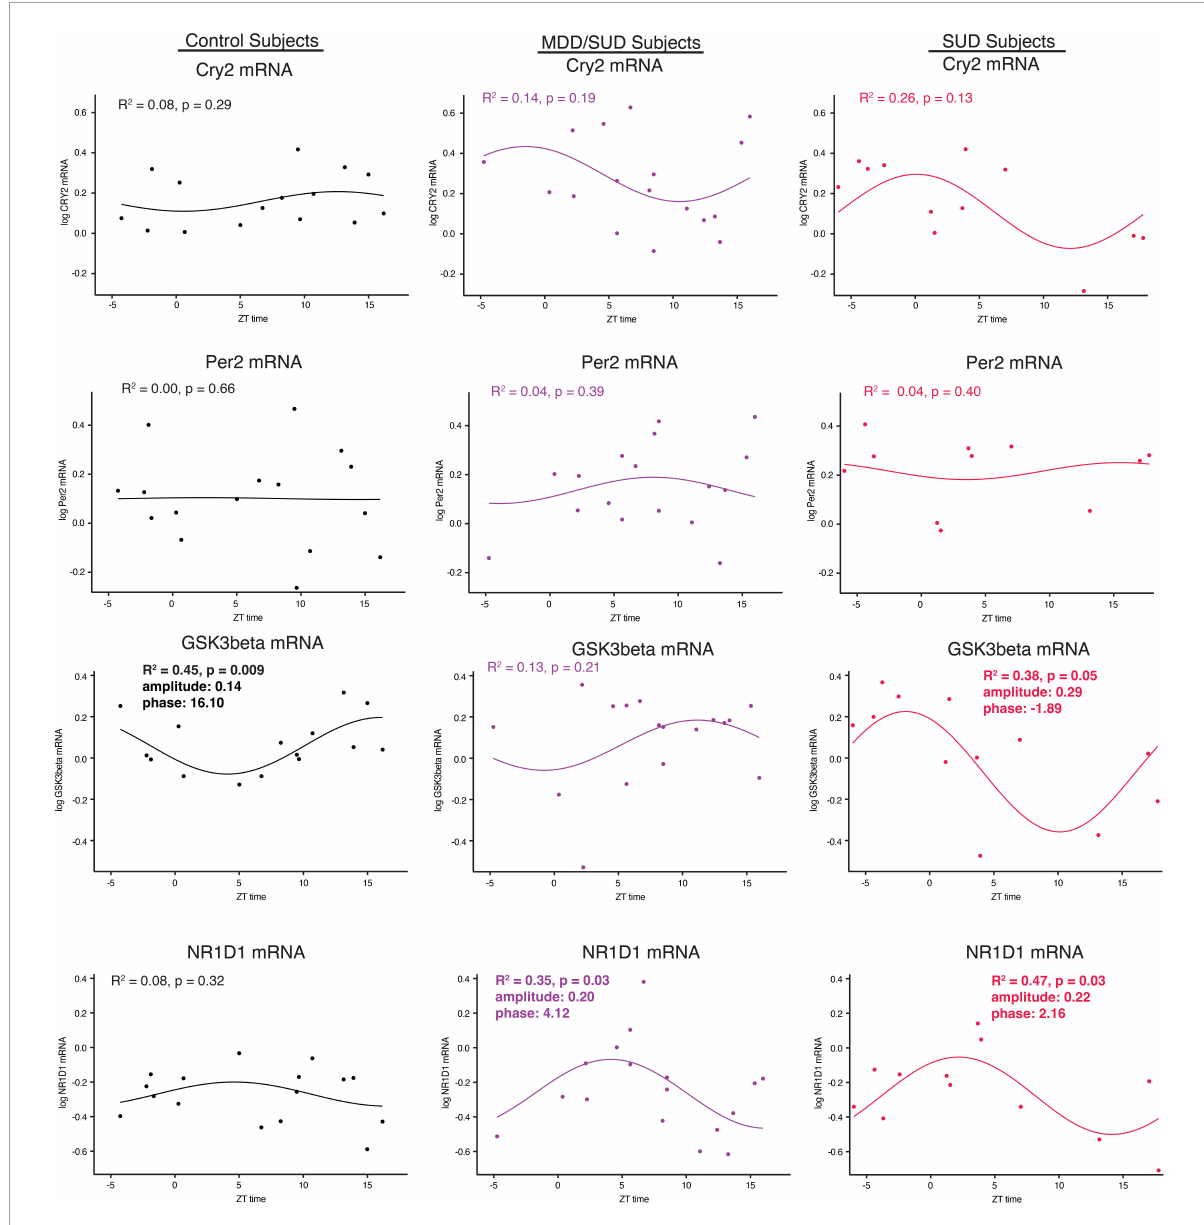
FIGURE7 Diurnal clock gene expression rhythms. Diurnal gene expression rhythms for clock genes in the human hippocampus. Expression level values in the scatterplots are indicated on the y axis with each dot representing an individual subject and the x axis representing ZT time of death values. The colored lines represent the fit sinusoidal curve for each marker in each diagnosis group. R 2 values and corresponding p -values represent significance of fit for diurnal expression rhythms. Significant diurnal expression rhythm was observed for Gsk3 β in control subjects. Enhanced rhythms were observed in subjects with SUD for Gsk3 β and Nr1d1 gene expression and for Nr1d1 in subjects with MDD/SUD. Phase and amplitude estimates and p -values are indicated on each scatterplot for outcome measures with significant R 2